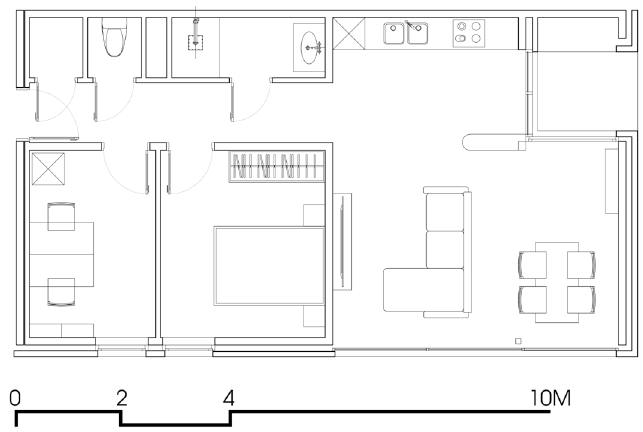
Steve chose a two-bedroom apartment to have an extra room for his home-office